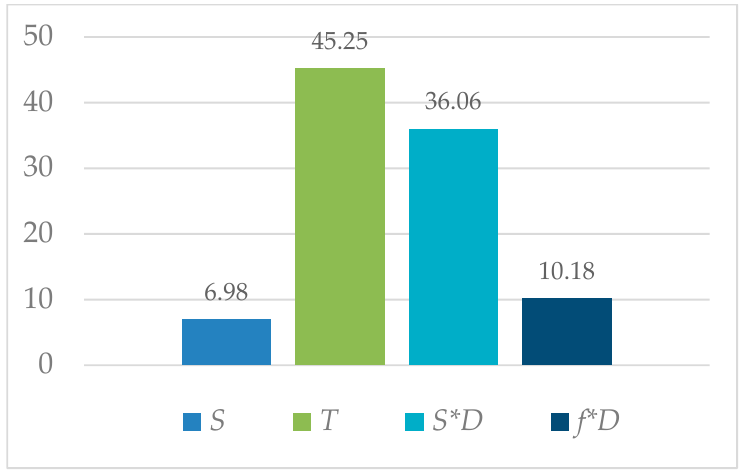
Figure 6. Percentage of contribution to the variability of the ANOVA model for each effect.